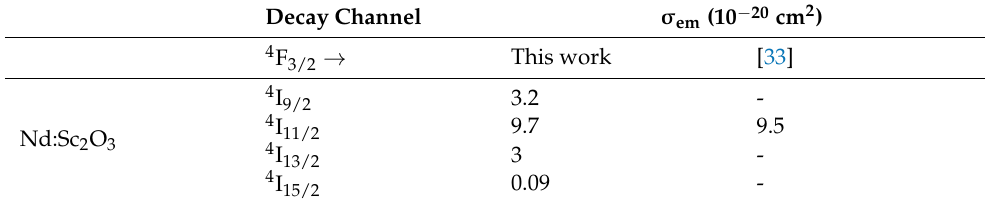
Table 4. Emission cross-sections of Nd:Sc 2 O 3 .